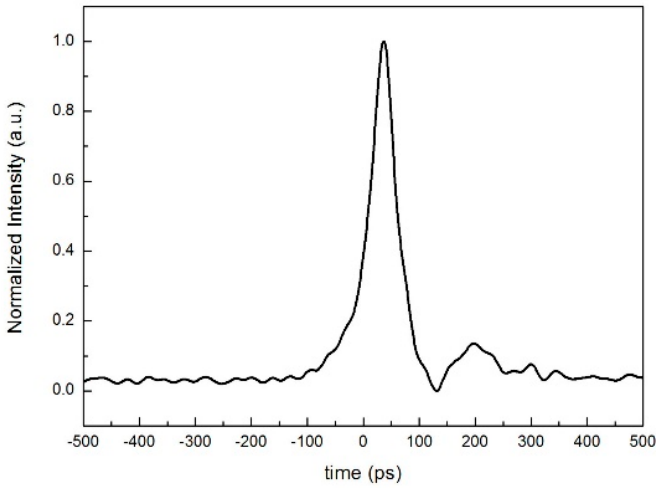
Figure 5. Pulse temporal width via the amplifying system.